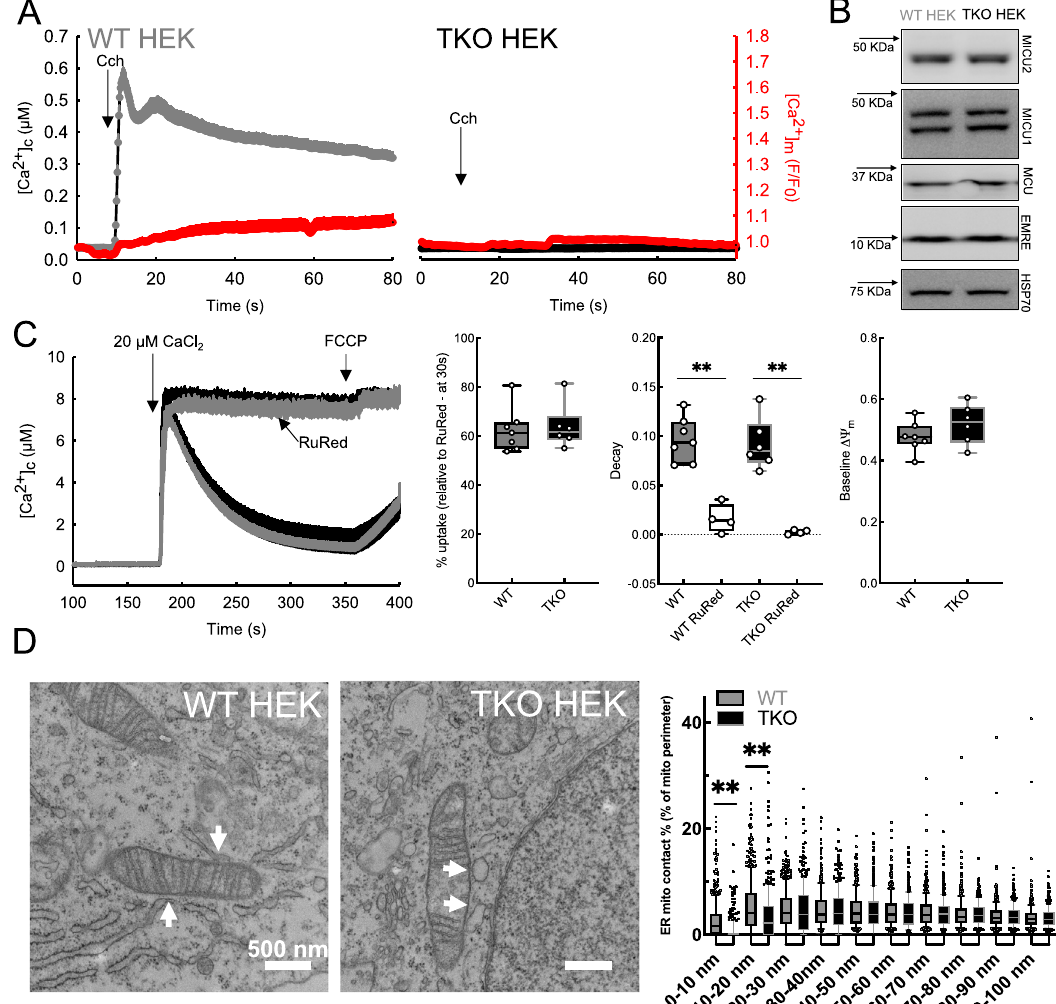
Fig. 1|HEKcellshaveweakER-mitochondrialCa 2+ transfer, but tight andIP3R- dependent ERMCs. A Average [Ca 2+ ] c response of WT (left, gray; n =25) and TKO (right,black; n =15)HEKcellstoCarbachol(Cch)andthecorrespondingchangesin the[Ca 2+ ] m (redtraces). B ImmunoblotsshowingtheproteinlevelsofMCU,MICU1, MICU2,andEMREinWTandTKOHEKlysates. C MeanmitochondrialCa 2+ clearance by permeabilized WT and TKO cells after the addition of 20 μ M CaCl 2 bolus in the presenceofthapsigargin(2 μ M)andCGP(20 μ M)withorwithoutRuRedtreatment. FCCP was added at the end of every run to release the accumulated Ca 2+ from the mitochondria. Box plots show the RuRed sensitive Ca 2+ uptake, the rate of Ca 2+ clearanceaftertheCa 2+ pulse,andthebaselinemitochondrialmembranepotential.